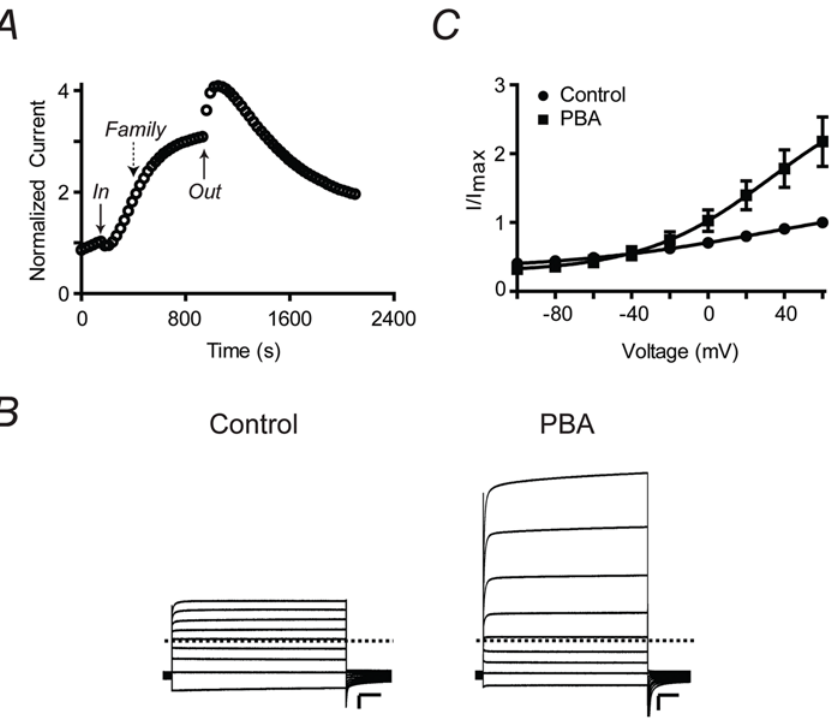
Figure 2. PBA activates Q1/E3 complexes. (A) Time course of Q1/E3 current measured in ND96 at + 40 mV at the end of a 2 s pulse. The current was normalized before PBA application. PBA initially inhibits then slowly potentiates channel current. (B) Families of currents recorded in high external potassium (50 mM) before and during treatment with PBA. Currents were elicited by 2 s test potentials from 2 100 to + 60 mV in 20 mV increments. The holding and tail potentials were 2 80 mV. Dashed line indicates zero current. Scale bars represent 1 m A and 0.5 s. (C) Voltage- activation curves for Q1/E3 calculated from tail current analysis. Solid curves represent Boltzmann fits to the data. Data are presented as the mean 6 SEM